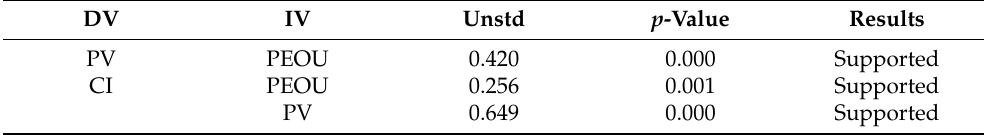
Table 5. Regression coefficient of research model I (TAM).